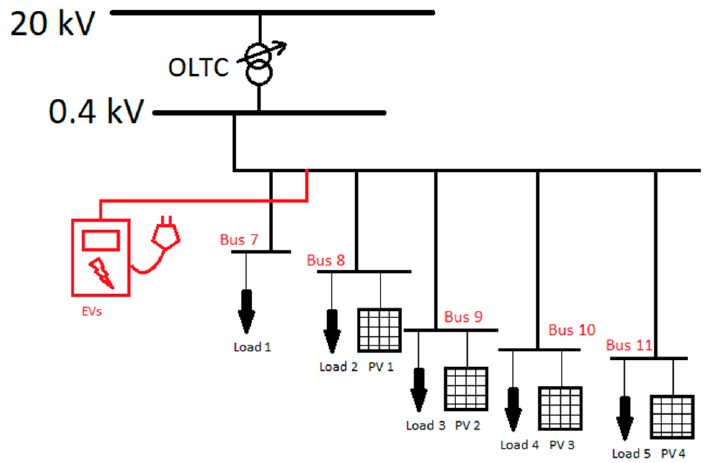
Figure 11. Simulated topology, with buses identified. on-load tap changer (OLTC), as well as the grid parameters, i.e., voltage and frequency